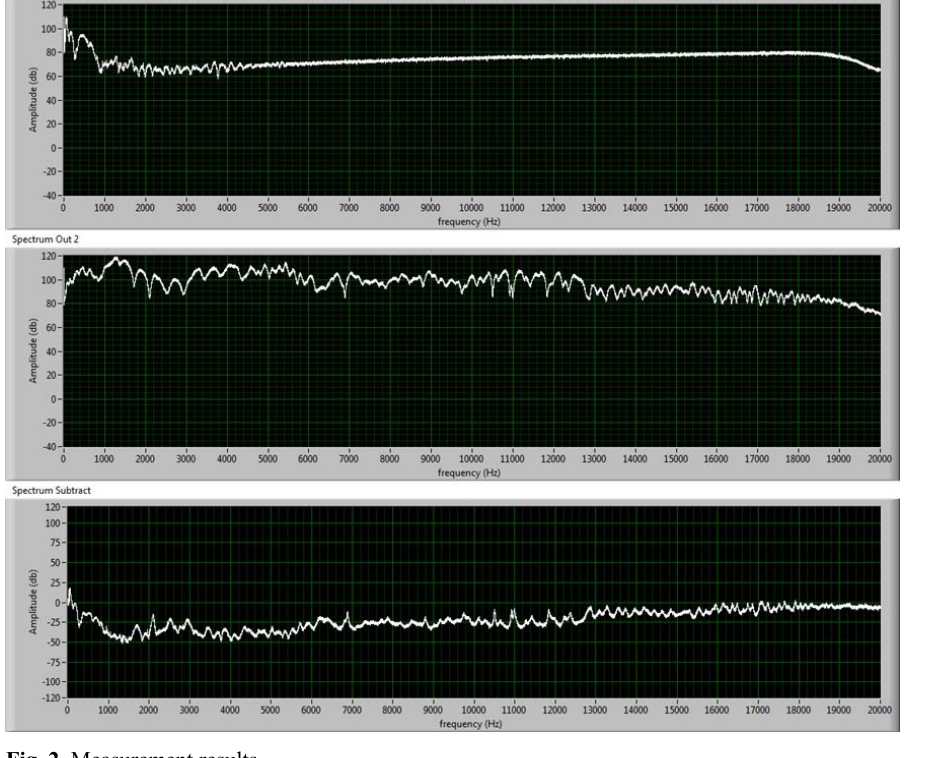
Fig. 2. Measurement